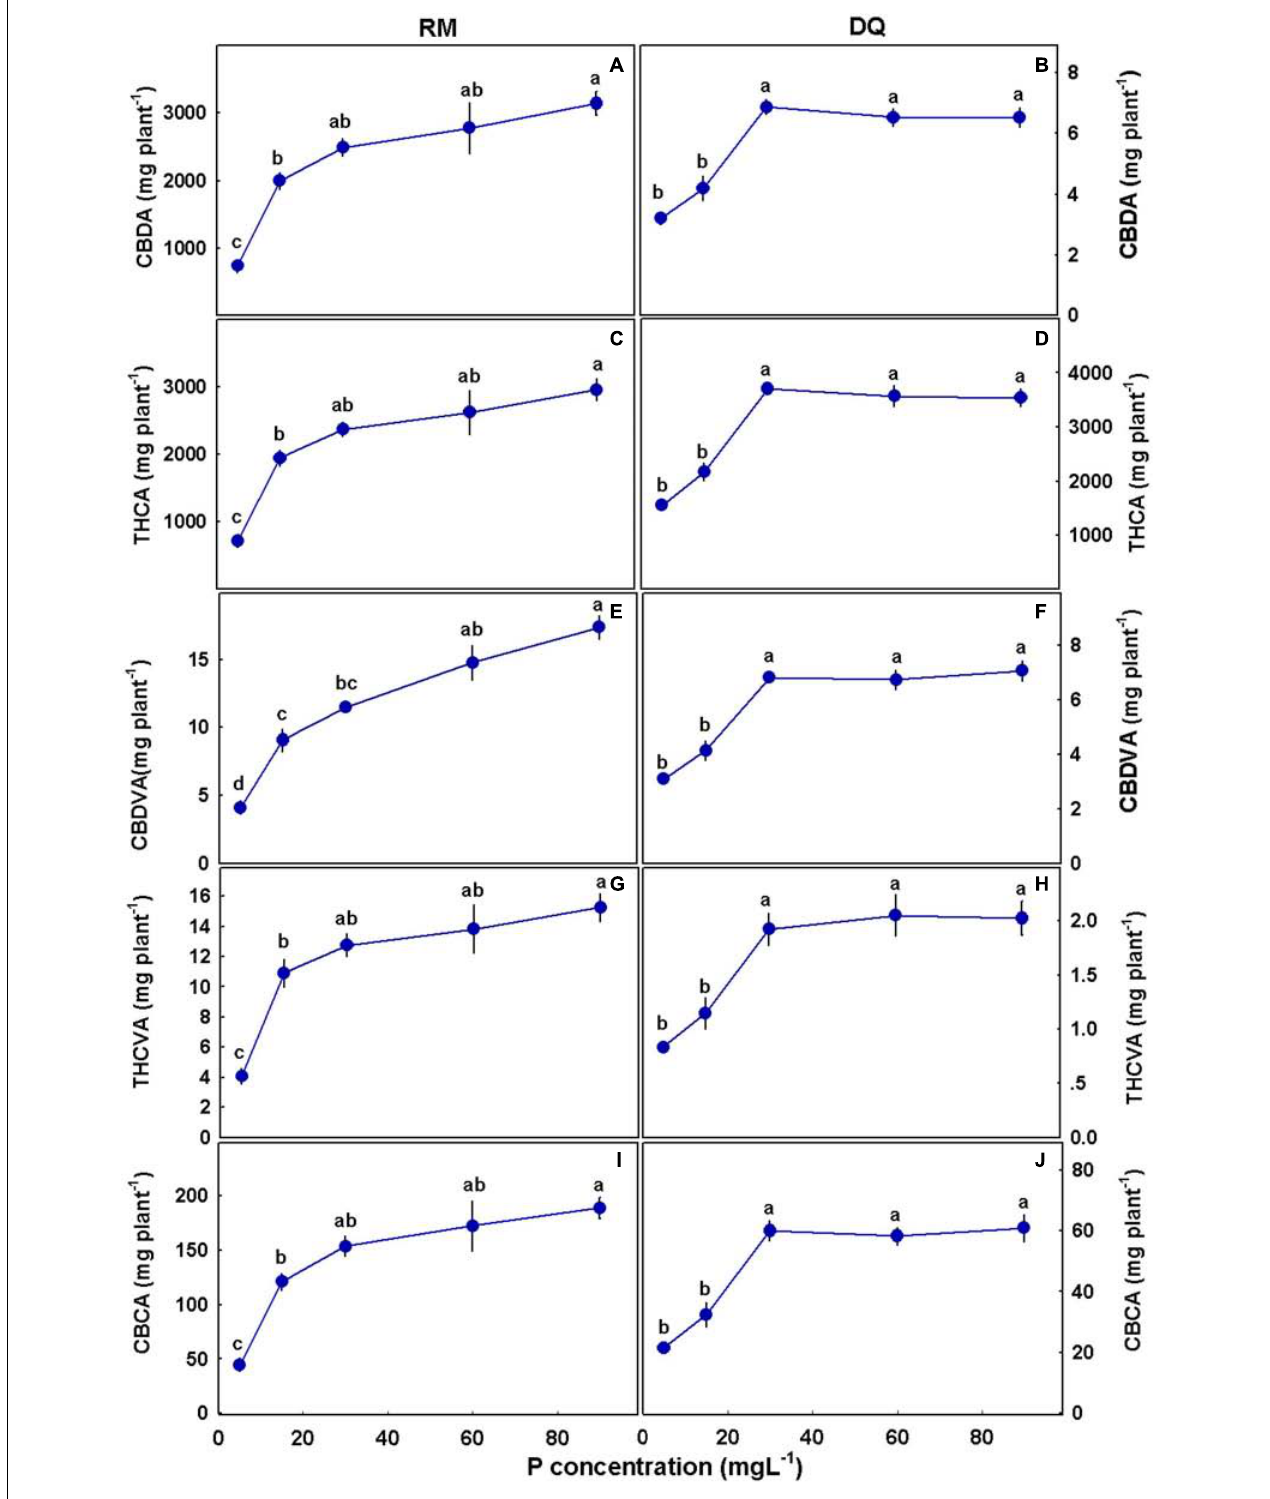
FIGURE 10 | Effect of P application on cannabinoid yield per plant for two medical cannabis cultivars, RM and DQ. Cannabidiolic acid (A,B) , (cid:49) 9 -tetrahydrocannabinolic acid (C,D) , cannabidivarinic acid (E,F) , (cid:49) 9 -tetrahydrocannabivarinic acid (G,H) , and cannabichromenic acid (I,J) . The presented data are averages ± SD ( n = 6). Different letters above the means represent significant differences according to Tukey’s honest significant difference test at α = 0.05.